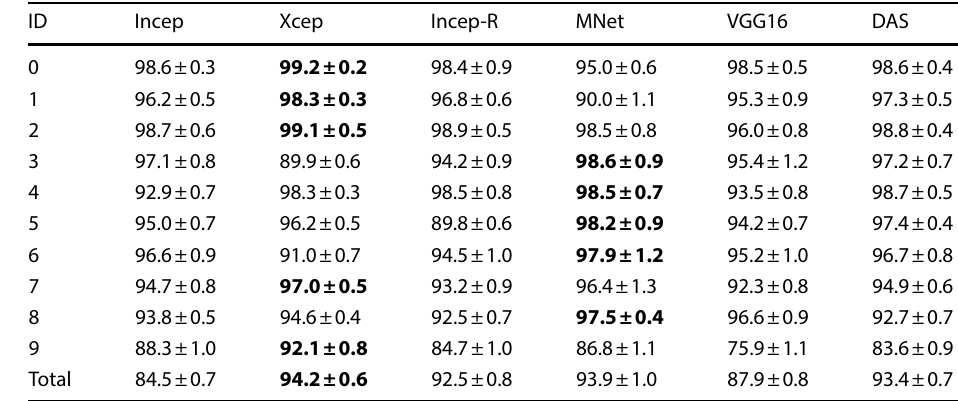
Table 3 Mean and Standard Deviation of Recall as a percentage for each model obtained in the test set after running each experiment 50 times with the TenGeoP- SARwv